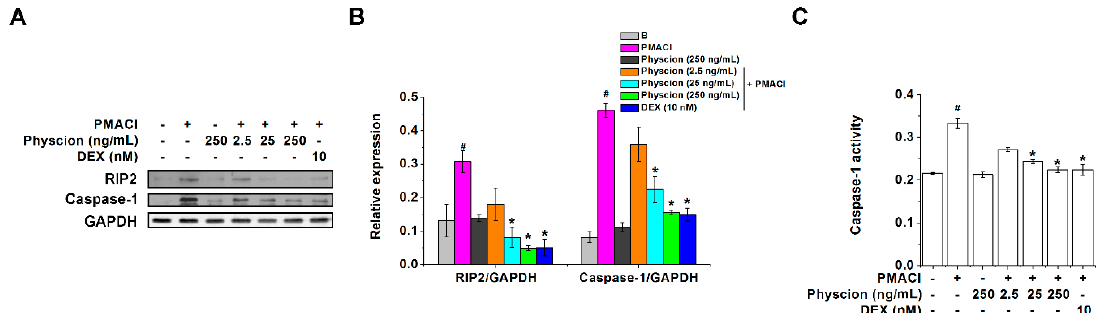
Figure 3. Physcion down-regulates RIP2 and caspase-1 expressions in PMACI-stimulated HMC-1 cells. ( A ) HMC-1 cells (5 × 10 6 ) were treated with physcion or DEX for 1 h and then stimulated with PMACI for 30 min. Representative immunoblots are shown. ( B ) Each relative intensity of protein levels was quantified by densitometry and shown as RIP2 / GAPDH and caspase-1 / GAPDH. ( C ) Caspase-1 activity was determined with a caspase-1 assay kit. # p < 0.05 vs. a non-stimulated group. * p < 0.05 vs. a PMACI-stimulated group.